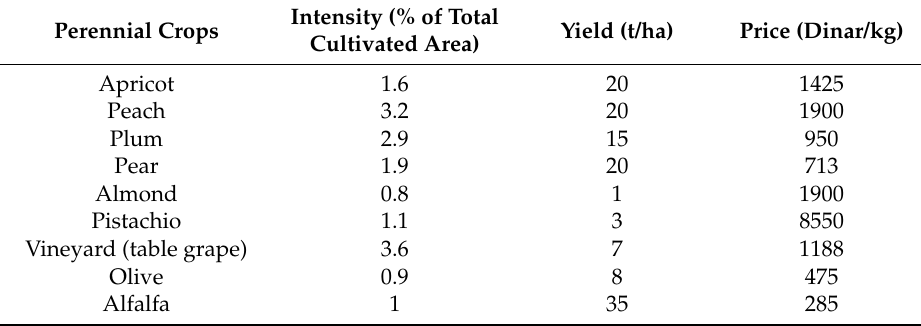
Table A5. The suggested cultivation patterns, yields, and prices suggested by agronomists for perennial crops.